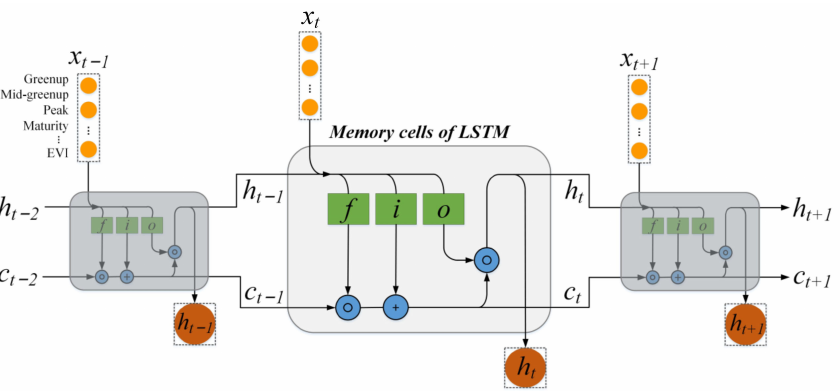
Figure 5. The architecture of a typical LSTM model. X t − 1 , X t , and X t + 1 represent the inputs from time t − 1 to time t + 1; h t − 2 , h t − 1 , h t , and h t + 1 represent the outputs; c t − 2 , c t − 1 , c t , and c t + 1 represent the cell states; f is the forget gate; i is the input gate; and o is the output gate.